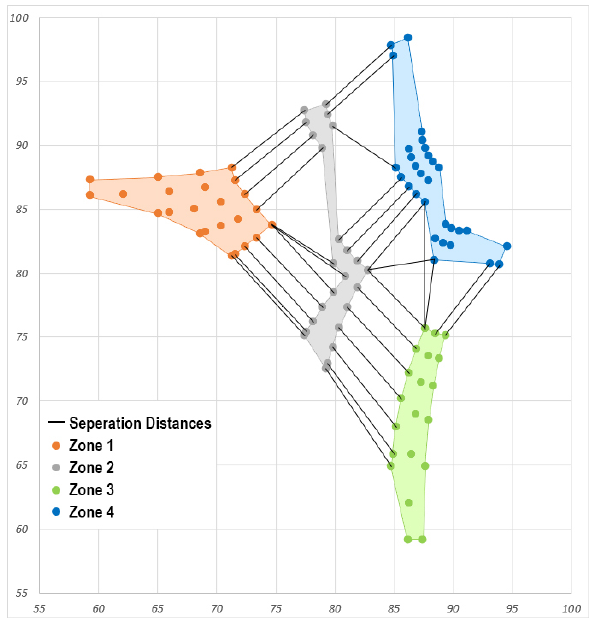
Figure 4. Class separation distances